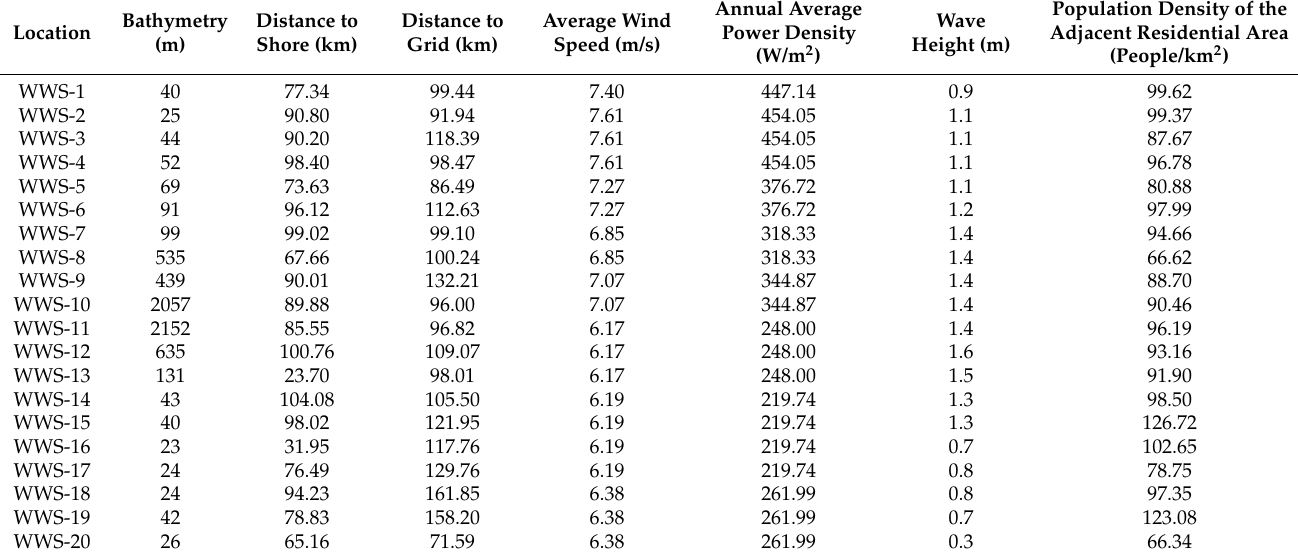
Table 4. The quantitative indicators of the B-DEA model.